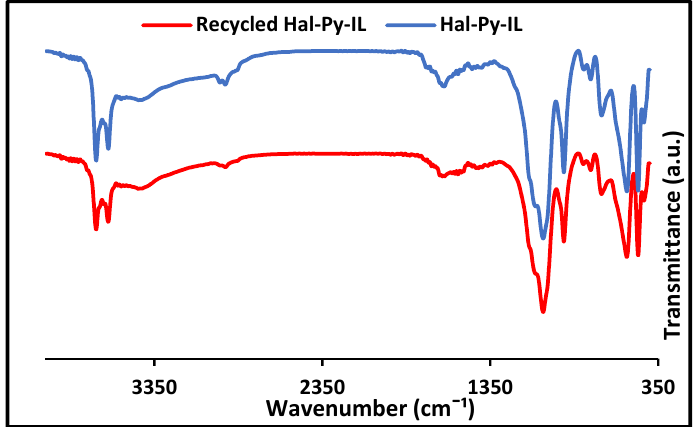
Figure 12. The FTIR spectra of fresh and reused Hal-Py-IL after eight runs.